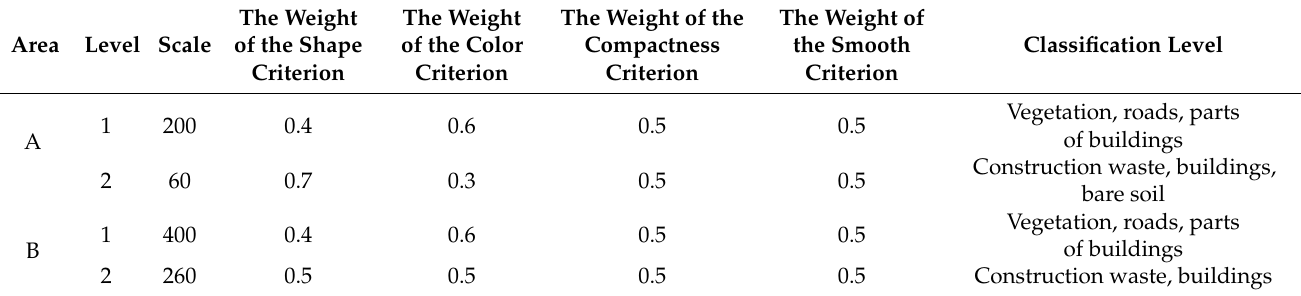
Table 2. The parameters of hierarchical segmentation.